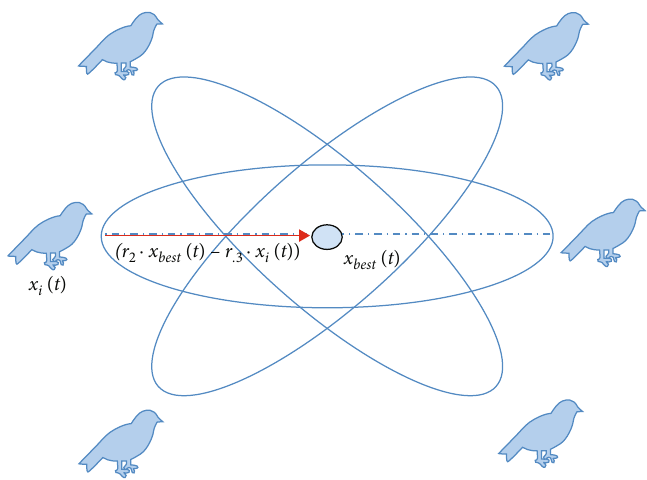
Figure 6: Producer ’ s somersault foraging behavior.